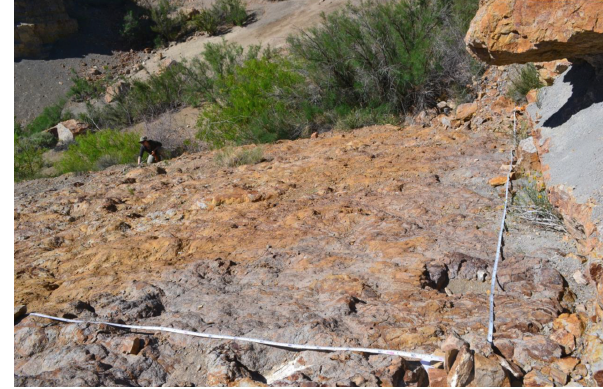
Figure 4. The grid system used in this study was based on two met- ric tape measures laid out perpendicular to each other to establish the locations for photographs. The positions of the individual grid intersections at 1m spacing were marked as shown in Fig. 5.